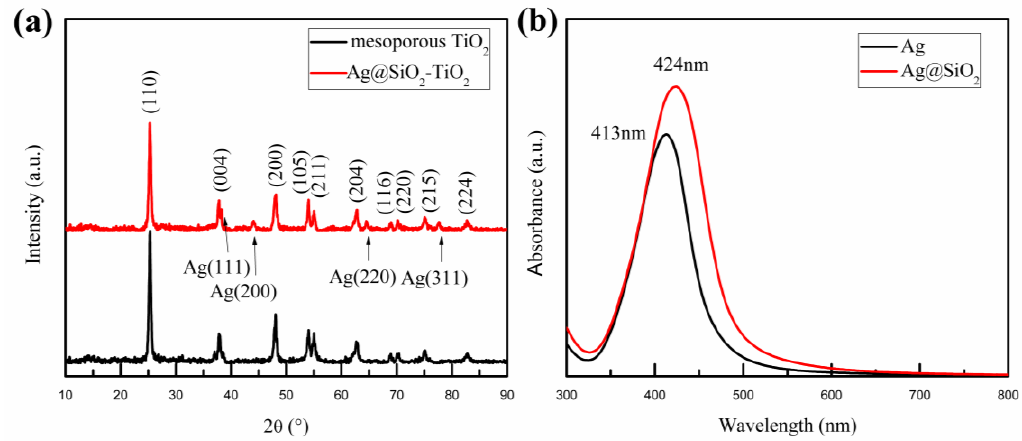
Figure 2. ( a ) XRD patterns of mesoporous TiO 2 and the Ag@SiO 2 -TiO 2 ; ( b ) Optical absorption spectra of 26 nm-Ag NPs and Ag@SiO 2 NPs dispersed in alcohol.